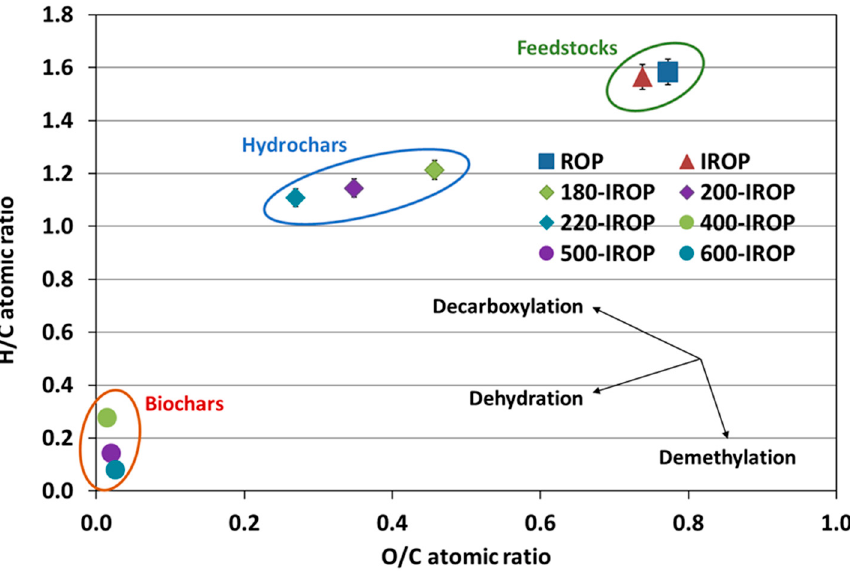
Figure 2. Van Krevelen diagram for IROP and its derived hydrochars and biochars produced at different temperatures.